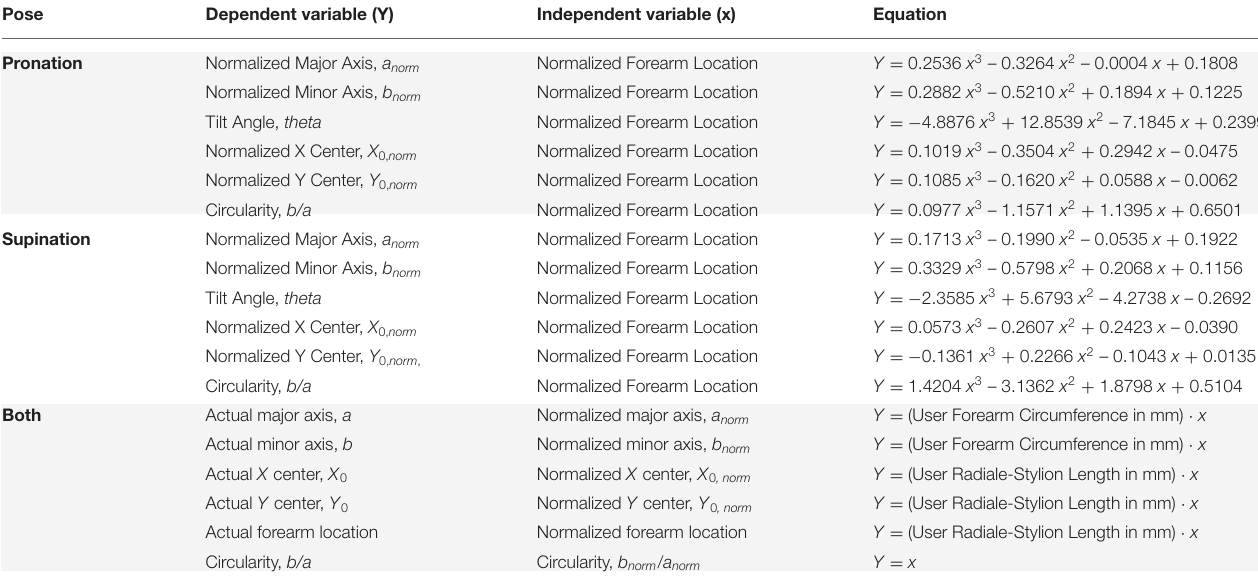
TABLE 3 | Forearm model equations include elliptical parameter best-fit equations from a 3rd-order polynomial fit through the CS2 ellipse parameters, Y , vs. normalized axial location, x